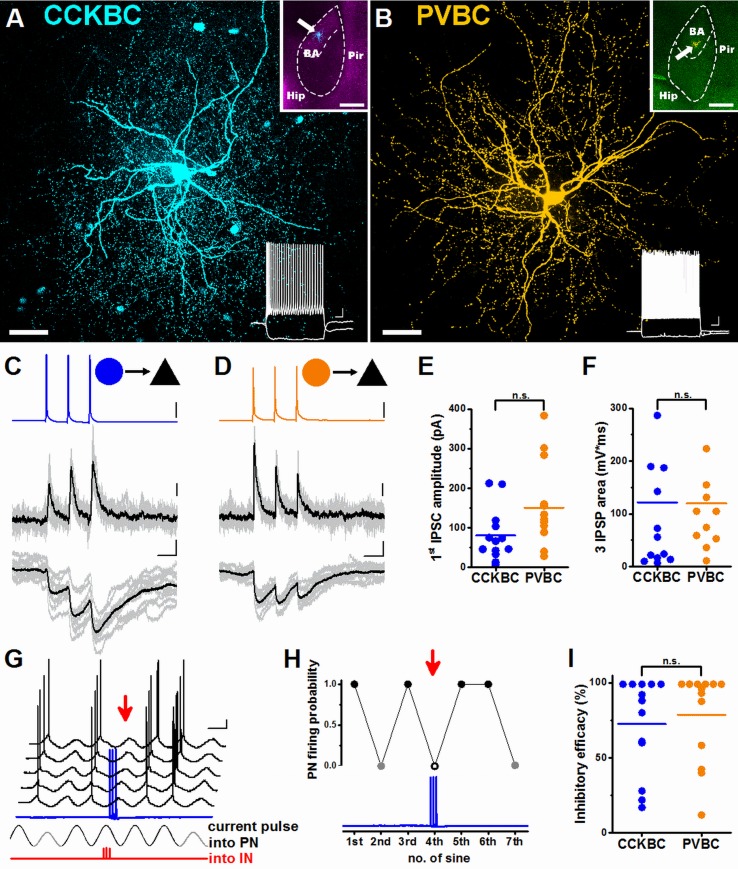
Similar potent inhibition of principal neuron (PN) activity by cholecystokinin-expressing basket cells (CCKBCs) and parvalbumin-containing basket cells (PVBCs).Maximum z intensity projection image of a CCKBC (A) and a PVBC (B). Scales: 50 μm. Upper insets in (A) and (B) indicate the positions of the recorded basket cells (BCs, white arrows) in horizontal slices prepared from mice expressing red fluorescent protein under the control of the Cck promoter (CCK-DsRed) and mice expressing enhanced green fluorescent protein under the control of the Pvalb promoter (PV-EGFP), respectively. Hip, hippocampus; BA, basal amygdala; Pir, piriform cortex. Scale for the insets: 500 μm. Lower insets show the firing patterns of the same BCs in response to a step current injection (+400 and −100 pA). Scales: 10 mV, 100 ms. (C, D) Representative inhibitory postsynaptic current (IPSC, middle traces) and potential (IPSP, lower traces) recordings in a CCKBC (blue)→PN (black) pair (C) or in a PVBC (orange)→PN pair (D) in response to 3 action potentials at 30 Hz (upper traces). Ten superimposed consecutive traces are in gray, average in black. Scales for (C) and (D): y: 20 mV/20 pA/0.5 mV, x: 20 ms. (E) CCKBCs and PVBCs give rise to IPSCs with similar amplitude (80.53 ± 18.36 pA, n = 13 CCKBC pairs and 150.38 ± 30.24 pA, n = 13 PVBC pairs, Mann–Whitney U test, p = 0.073) (S3 Data), and (F) 3 IPSPs with the similar area (121.83 ± 43.71 mV*ms, n = 13 CCKBC pairs and 119.78 ± 30.35 mV*ms, n = 11 PVBC pairs, Mann–Whitney U test, p = 0.45) (S3 Data) recorded in PNs. (G) Sinusoidal current trains with peak-to-peak amplitude of 30 pA (gray cycles) and 50 pA (black cycles) were injected into a PN to initiate firing, and 3 action potentials were evoked in the presynaptic CCKBC (blue) at the fourth cycle (red arrow). Schematic representation of the injection of 3 current pulses into the presynaptic interneuron (IN) at 30 Hz is shown in red. Voltage traces are offset for clarity. Scale: 10 mV, 200 ms. (H) Raw data of the experiments are shown in (G). Black and gray dots refer to the firing probability observed at the sinusoid current amplitudes of 50 pA and 30 pA, respectively. An open circle indicates the cycle when the presynaptic interneuron fired 3 action potentials. (I) Comparison of the inhibitory efficacy of CCKBCs and PVBCs (72.53 ± 8.80%, n = 13 CCKBC pairs and 78.70 ± 8.29%, n = 13 PVBC pairs, Mann–Whitney U test, p = 0.63) (S3 Data). Each data point on the plots represents an average obtained in a pair recording, and lines represent means.